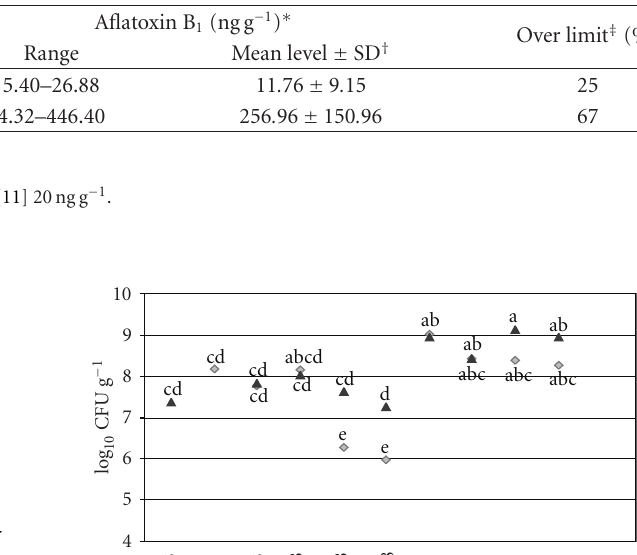
Table 5: Incidence of AFB1 in brewer’s grain at 0 and 7 days of storage.